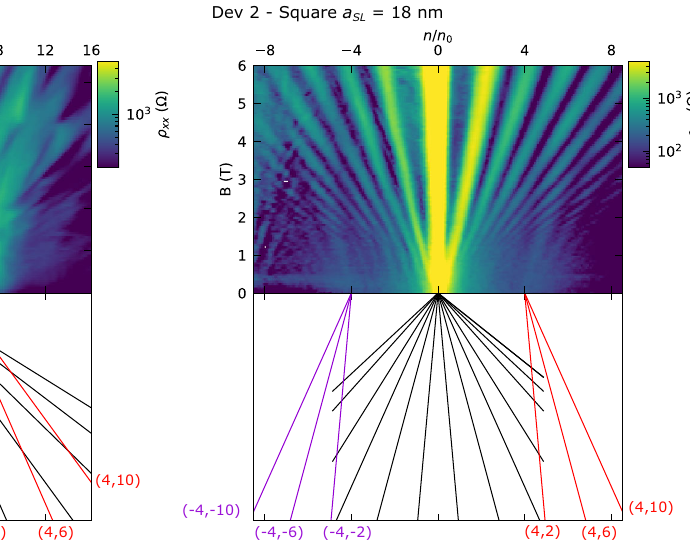
Fig. 4 | Longitudinal magneto-resistance measurements of devices Dev 1 and Dev 2. For Dev 1 ( V BG =70 V),weobserve a rich Hofstadter butter fl y where Landau fans emerge from fi lling fractions n = n 0 =0,±4,±8. Red arrows indicate resistance dipscorrespondingtoanintegerfractionofthe fl uxquantum ϕ = ϕ 0 =1 = 3,1 = 2,1.For